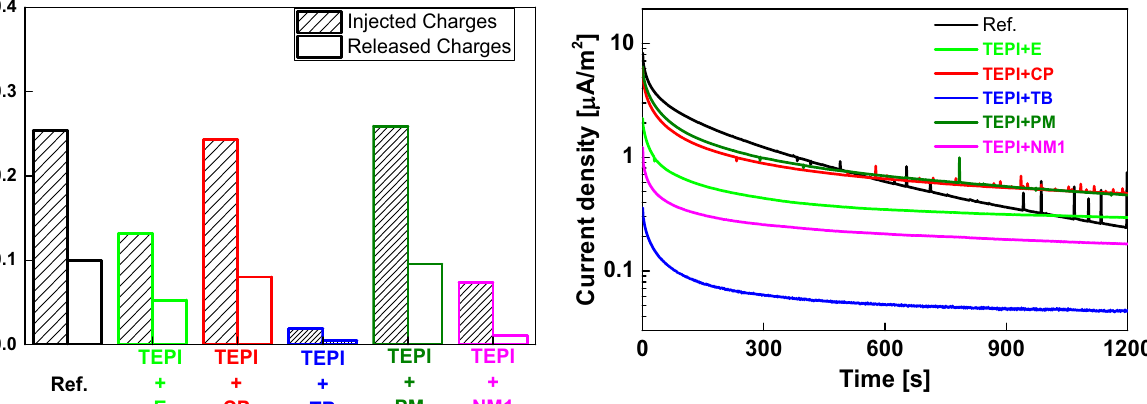
Figure 16: Charging current density during the isothermal polari - zation